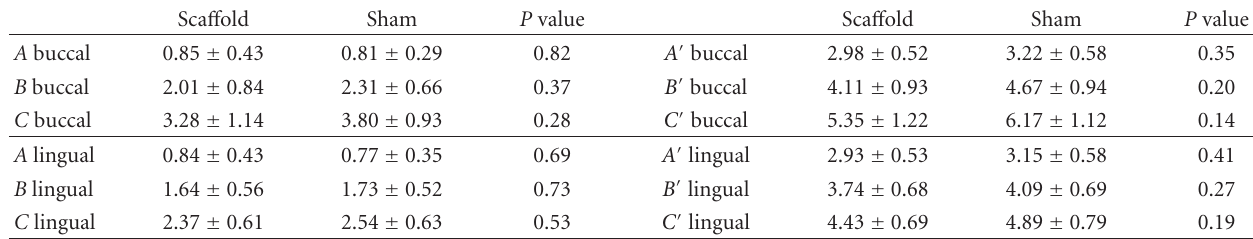
Table 2: Mean values and standard deviations of alveolar wall thickness ( A – C ) and total bone thickness ( A (cid:3) – C (cid:3) ) on di ff erent levels: 1mm ( A ), 3mm ( B ), and 5mm ( C ) apical of the buccal and lingual bone crest. Values are given in millimetres after 6 weeks of healing. No significant di ff erence was detected between sca ff old and sham groups. n =